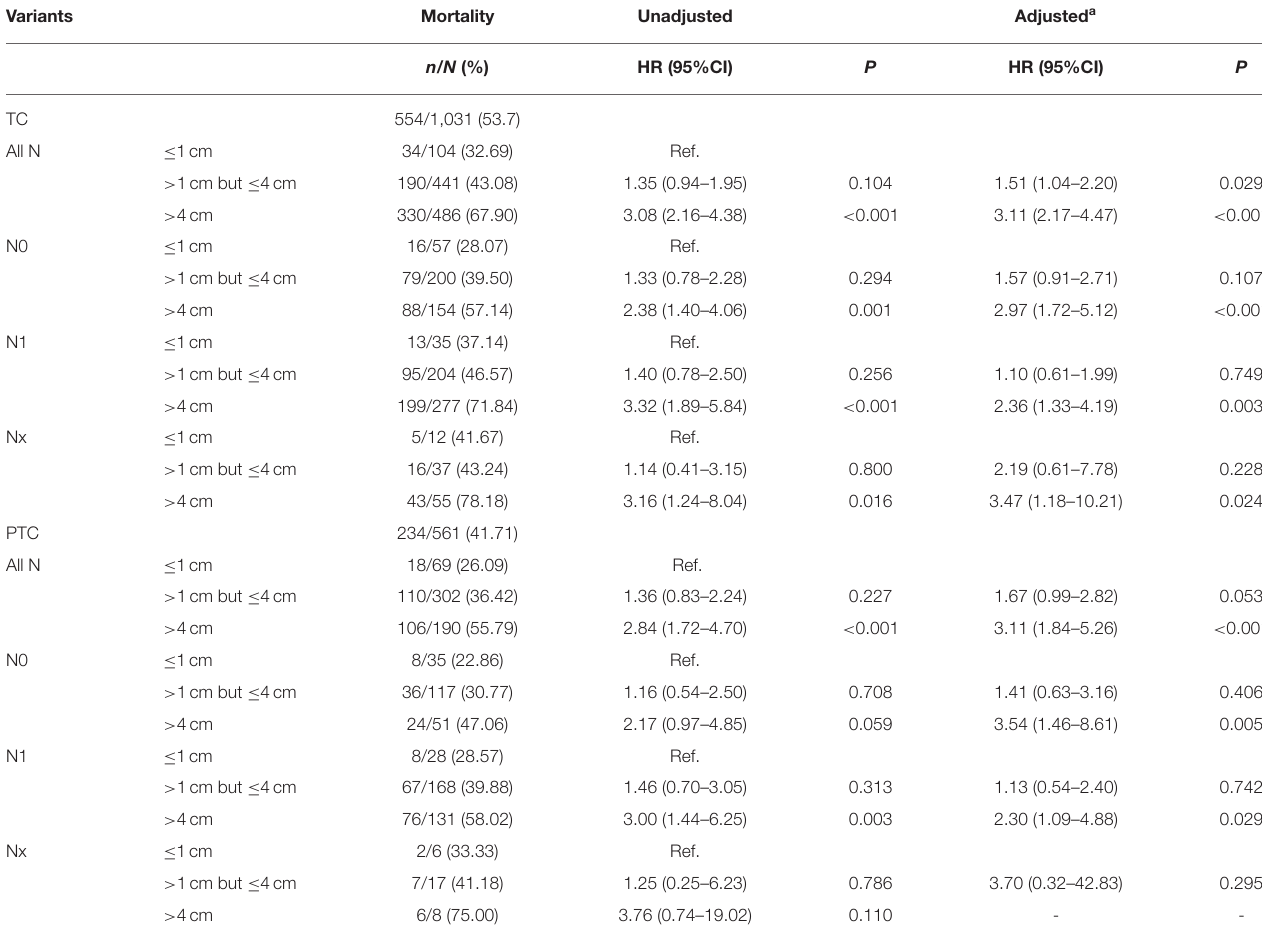
TABLE 2 | The Association between tumor size and thyroid cancer specific mortality in patients with different N category (SEER database years of 2004–2016). Variants Mortality